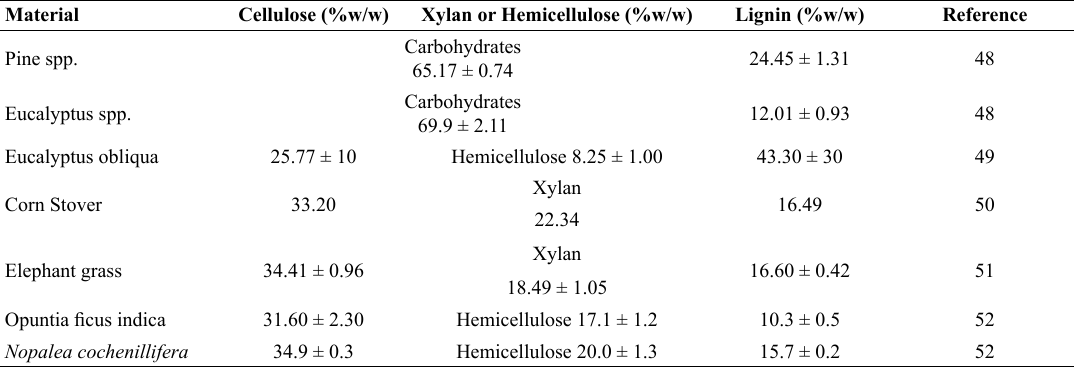
Table 2. Lignocellulosic composition of some lignocellulosic materials.